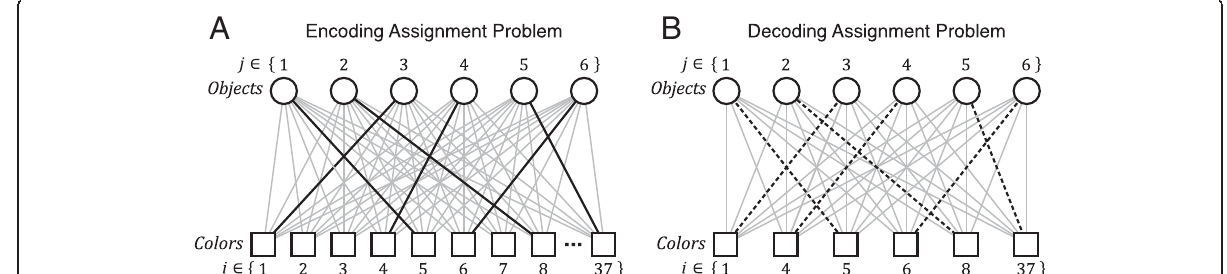
Fig. 2 Bipartite graphs illustrating color-object assignments. a In encoding, the designer determines optimal assignments between colors and objects, given the merit scores. Here, there are more colors than objects. Black edges represent assigned color-object pairs and gray edges represent unassigned color-object pairs. b In decoding, observers try to infer how the designer encoded color-object assignments. Dashed black edges represent inferred assignments that match the encoded